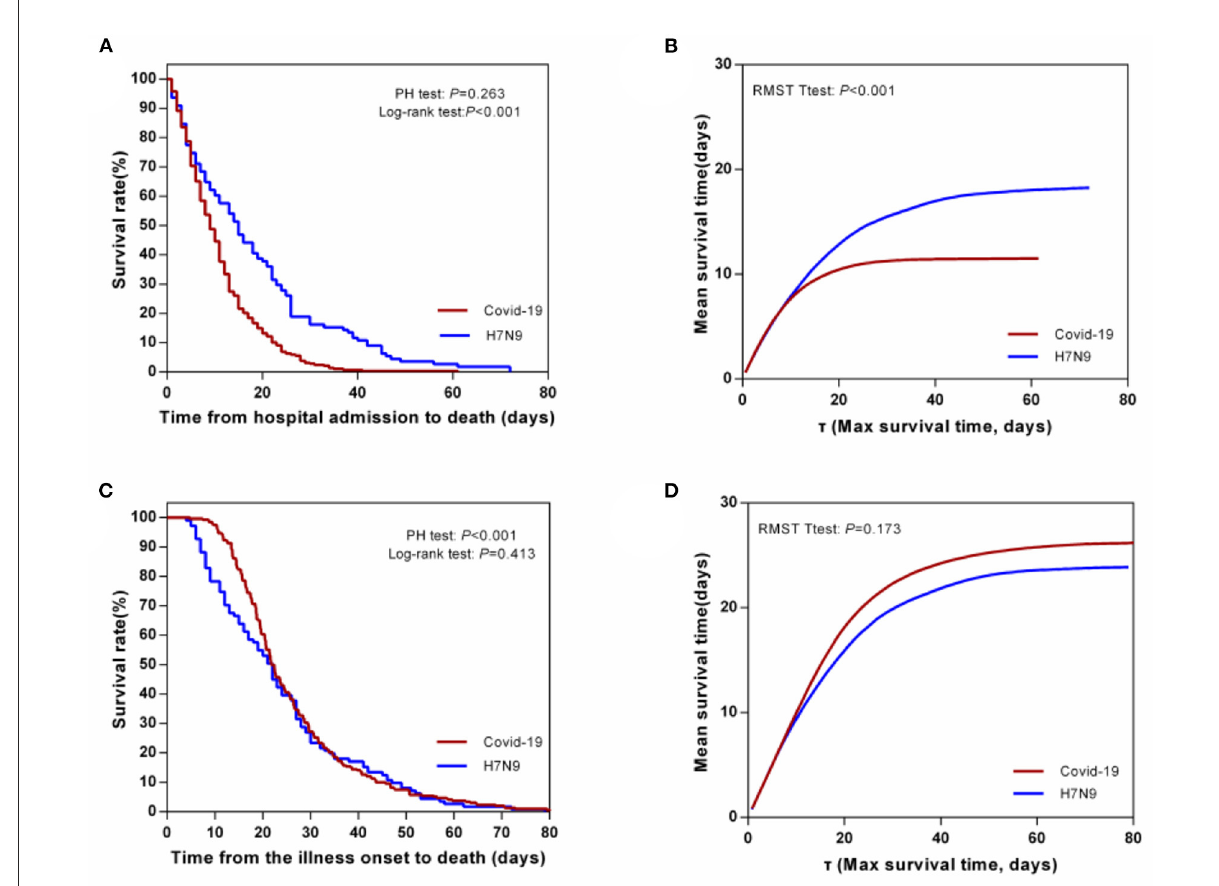
FIGURE2 Survival time from hospital admission and illness onset to death by log-rank test and RMST curves. (A) Survival time from hospital admission to death by log-rank test. (B) Survival time from hospital admission to death by RMST curves. (C) Survival time from illness onset to death by log-rank test. (D) Survival time from illness onset to death by RMST